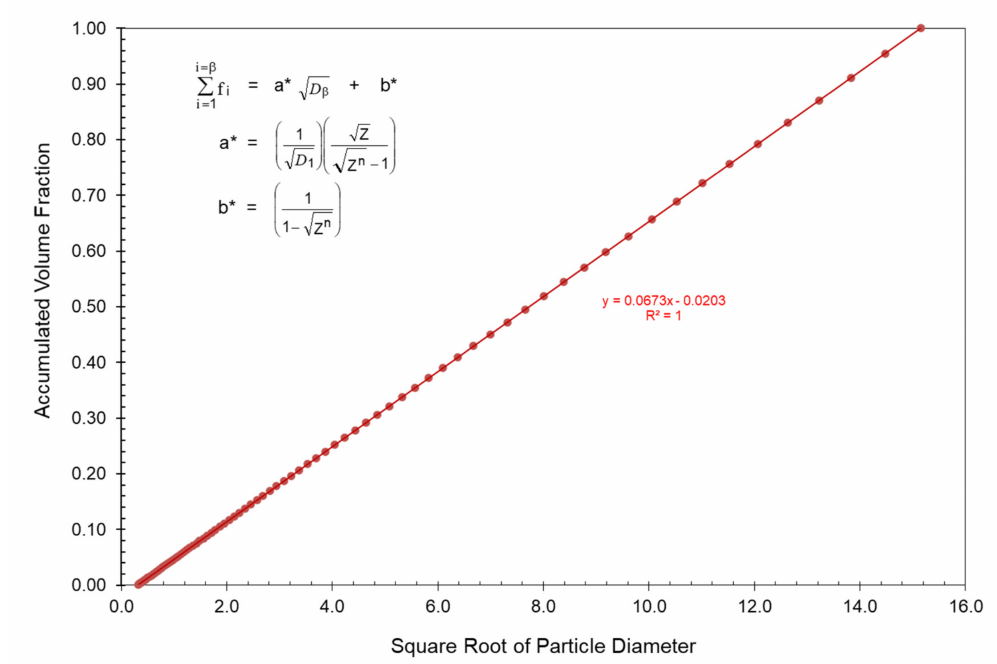
Figure 12. Optimum straight line distribution with the same starting particle and the same ending particle with a constant slope and same ratio between particles (D min = 0.1 and D max = 229.6 and Z =